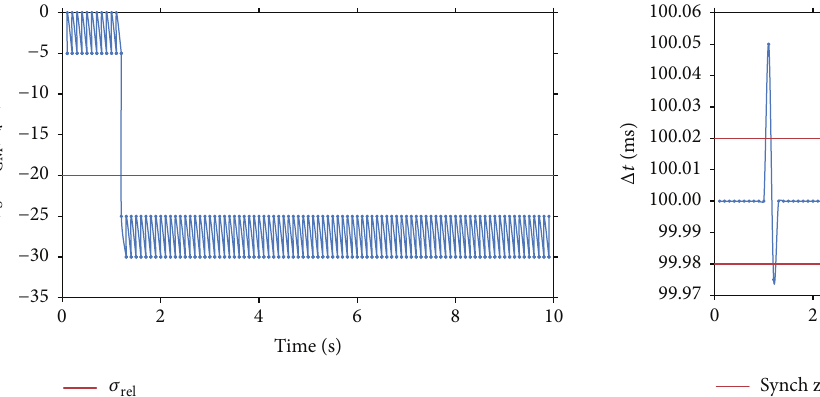
Figure 9: Time deviation between the grandmaster clock and the slave clock. Constant delay, 𝑑 adv = 50 𝜇 s.